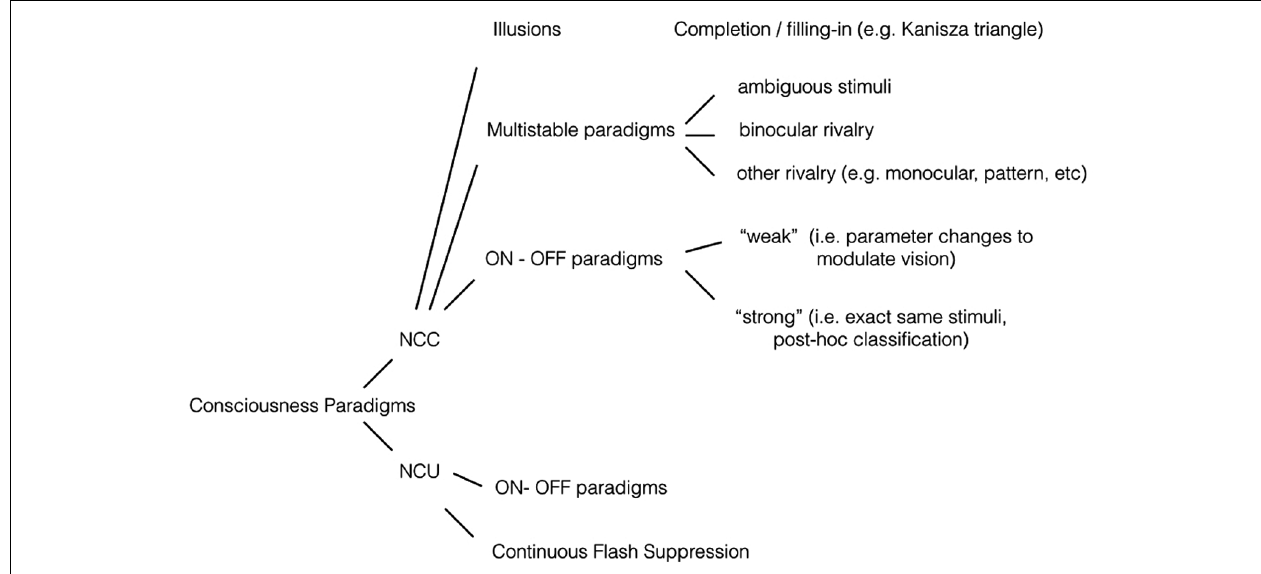
absence of a conscious percept, as opposed to presence of percept A vs presence of percept B as in multistable paradigms.The strong version involves no changes in stimulation, the weak version does involve parameter changes. For more details see main text. NCU (neural correlates of “unconsciousness”) paradigms . ON–OFF paradigms : An ON – OFF paradigm can be used for NCC studies if brain activity is contrasted in the ON vs the OFF condition.The same stimuli and setup can be useful for NCU studies, if brain activity is contrasted in the OFF condition vs rest. In other words; which brain processes still obtain if a stimulus is presented but not consciously perceived? Continuous flash suppression : A variant of the binocular rivalry paradigm, in which conscious perception is heavily biased towards one eye through repeated salient stimulation of that eye, while the second eye receives a weaker stimulus.That weaker stimulus of interest is thus suppressed for prolonged periods of time, allowing analysis of brain processes nevertheless responding to